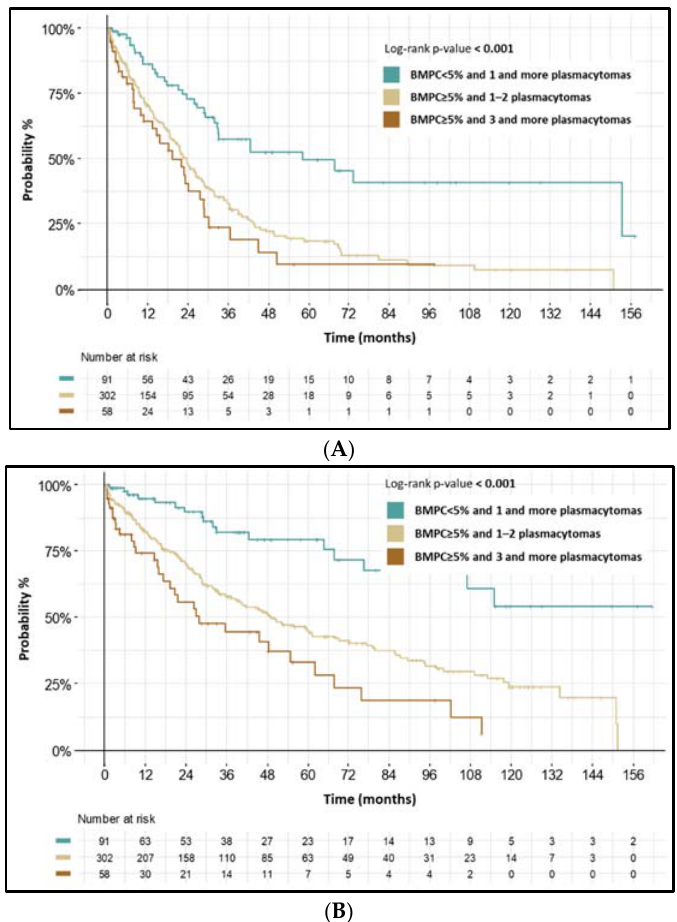
Figure 2. ( A ) PFS from 1st line—by tumor burden in NDMM patients with PS plasmacytomas. ( B ) OS from 1st line—by tumor burden in NDMM patients with PS plasmacytomas. Table 3. Descriptive characteristics according to tumor burden in NDMM patients with PS plasmacy-